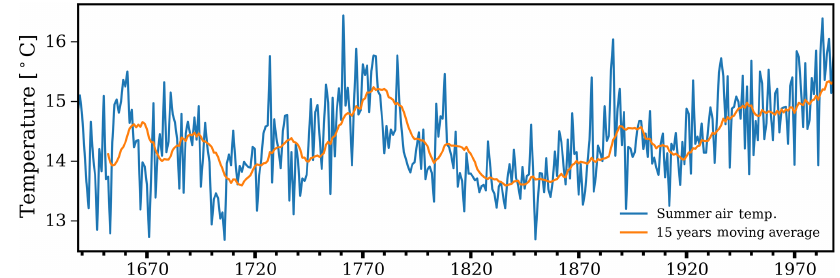
Figure 3. Reconstructed summer (June–July) air temperature based on tree rings for the period 1638–1988 along with its 15-year moving average.